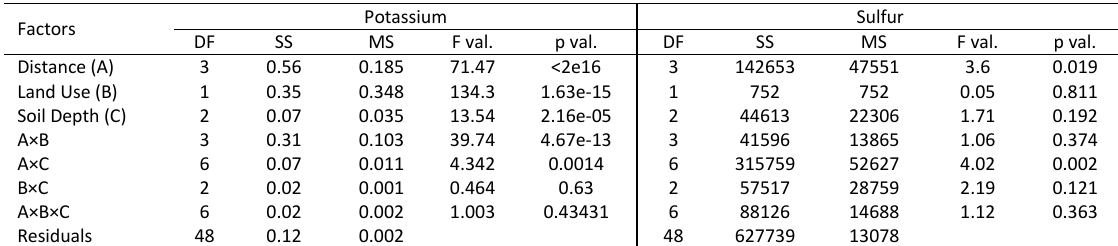
Table 4: Three way analysis of variance table for soil K and Son distance (km) from the coast, land use type (agriculture vs. fallow land) and different soil depth. Significant differences are marked in bold in the table (α=0.05) Potassium Sulfur Factors DF SS MS F val. p val. DF SS MS F val. p val. Distance (A) 3 0.56